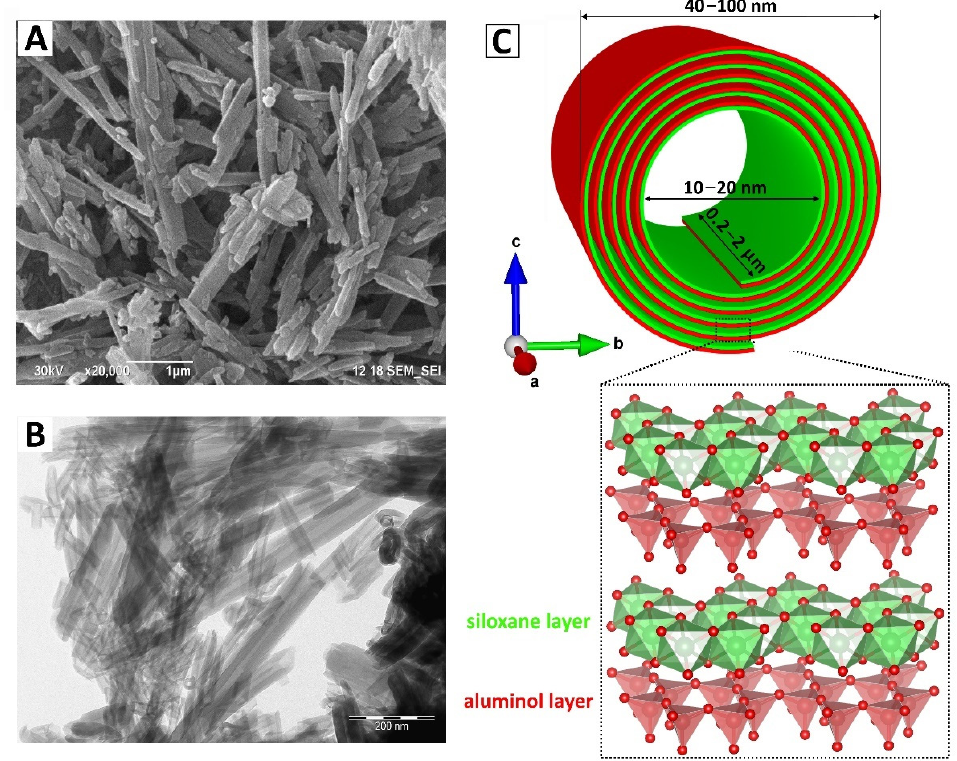
Figure 1. Morphology (visualized by transmission electron microscopy (TEM) ( A ) and scanning electron microscopy (SEM) ( B )), and schematic representation of crystal structure ( C ) of halloysite.